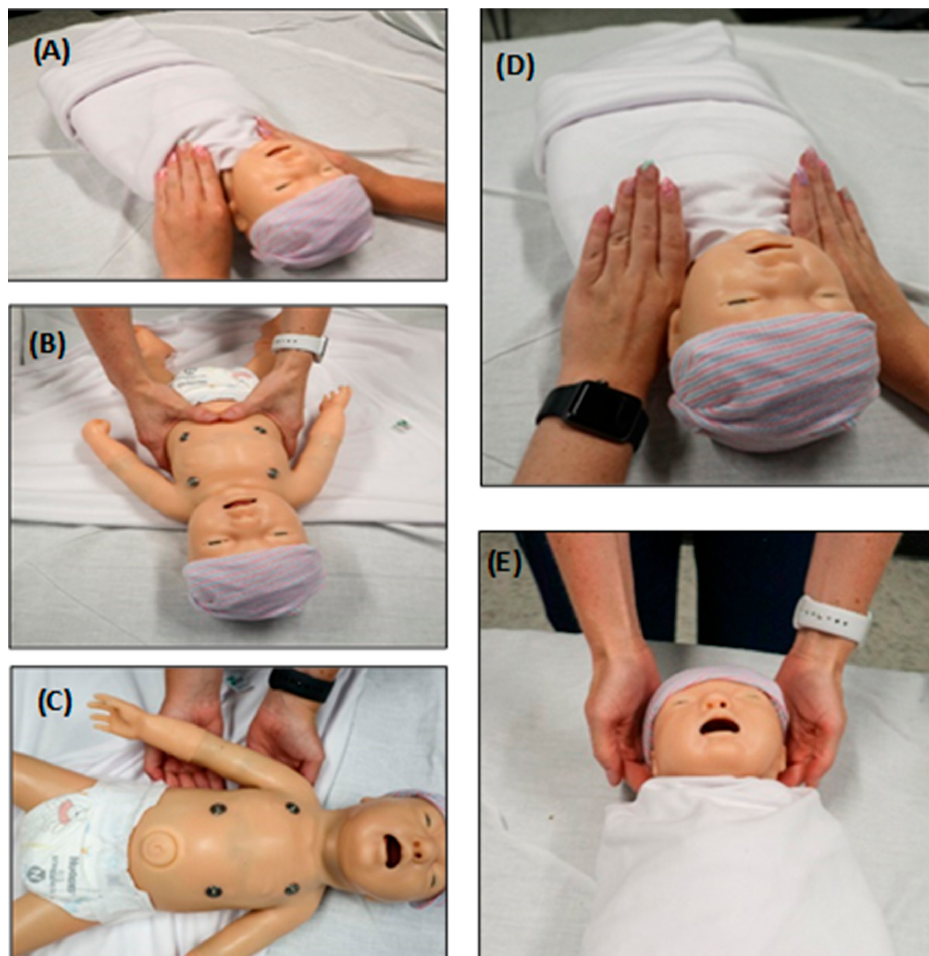
Figure 1. OMT techniques often utilized on babies in the NICU. The insets represent hand placement of different OMT techniques using a plastic neonate model. ( A ) Lymphatic pump technique (LPT). This technique uses a sequential pneumatic compressive pumping action that ameliorates swelling and increases immune surveillance by mimicking the lymphatic system. One such technique, the thoracic pump technique, is demonstrated in the image. ( B ) Diaphragm treatment (DPT). This tech- nique can ameliorate a dysfunctional thoracic diaphragm and optimize its physiologic function. This technique also influences the thoracic and lumbar spine, ribs, and sternum. ( C ) Balanced liga- mentous tension (BLT). This includes manipulation of joint ligaments to a precise balance point,